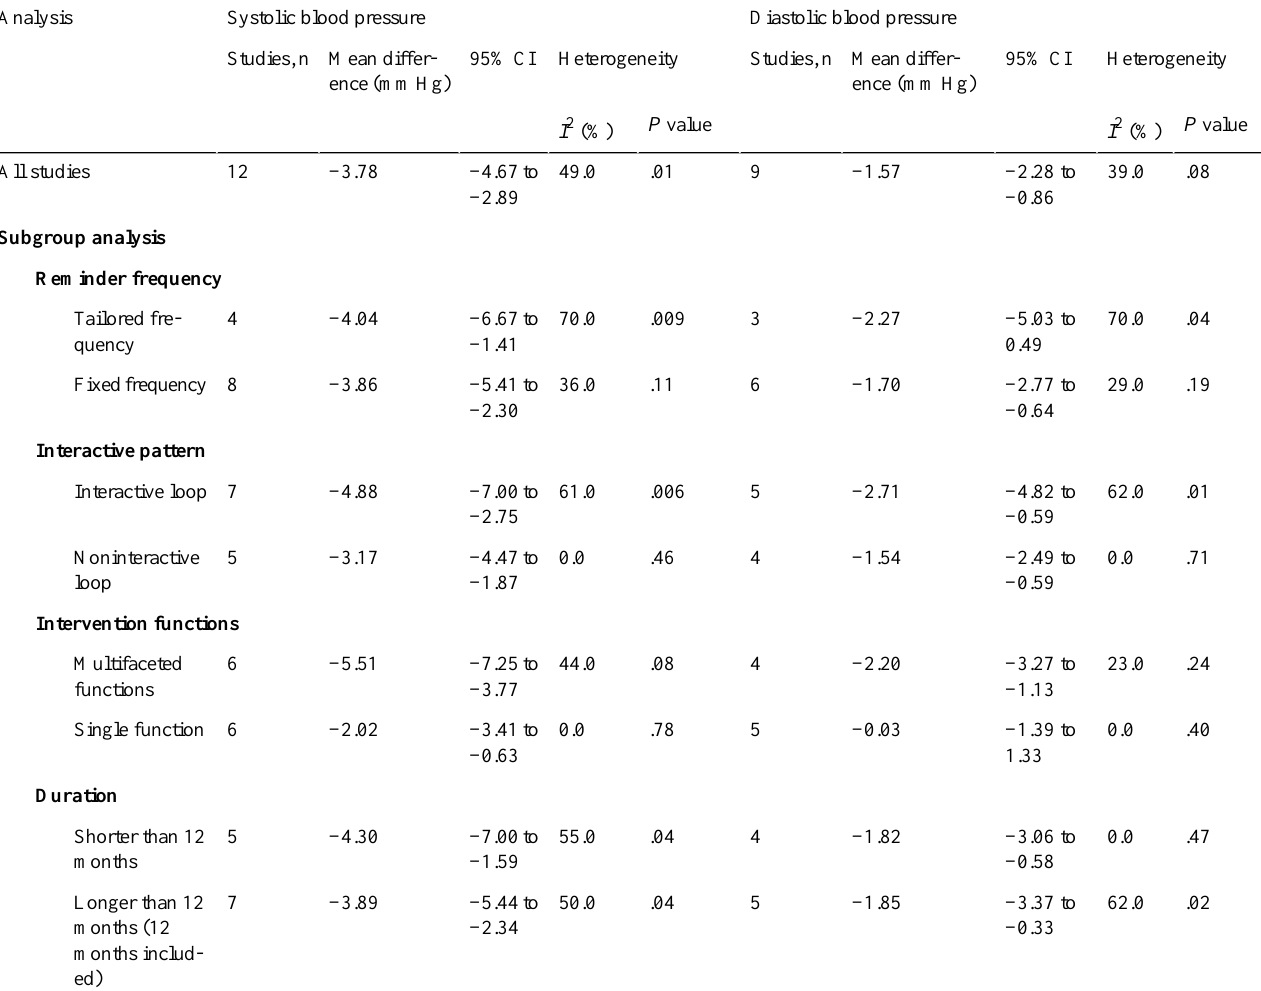
Table 1. Results from the subgroup analyses of mean differences in systolic blood pressure and diastolic blood pressure.